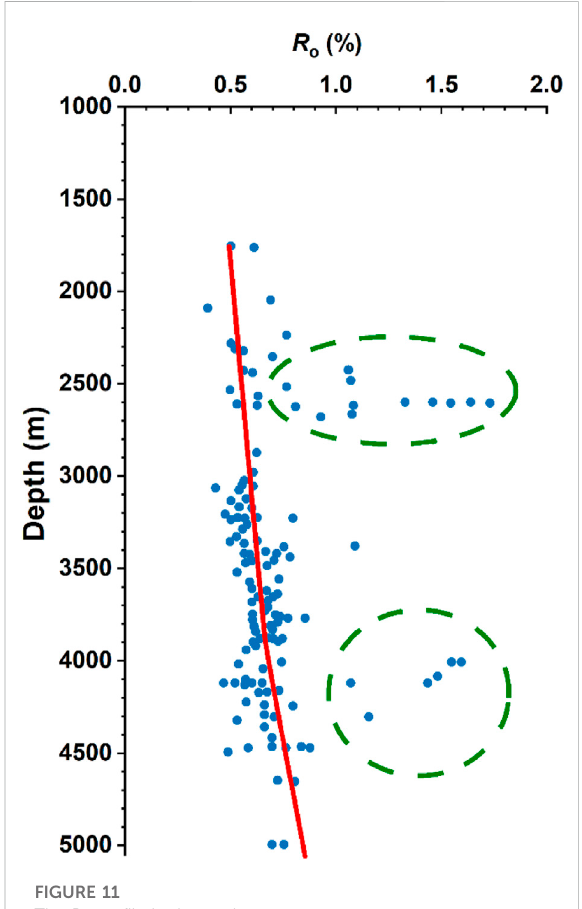
FIGURE 11 The R o pro fi le in the study area.